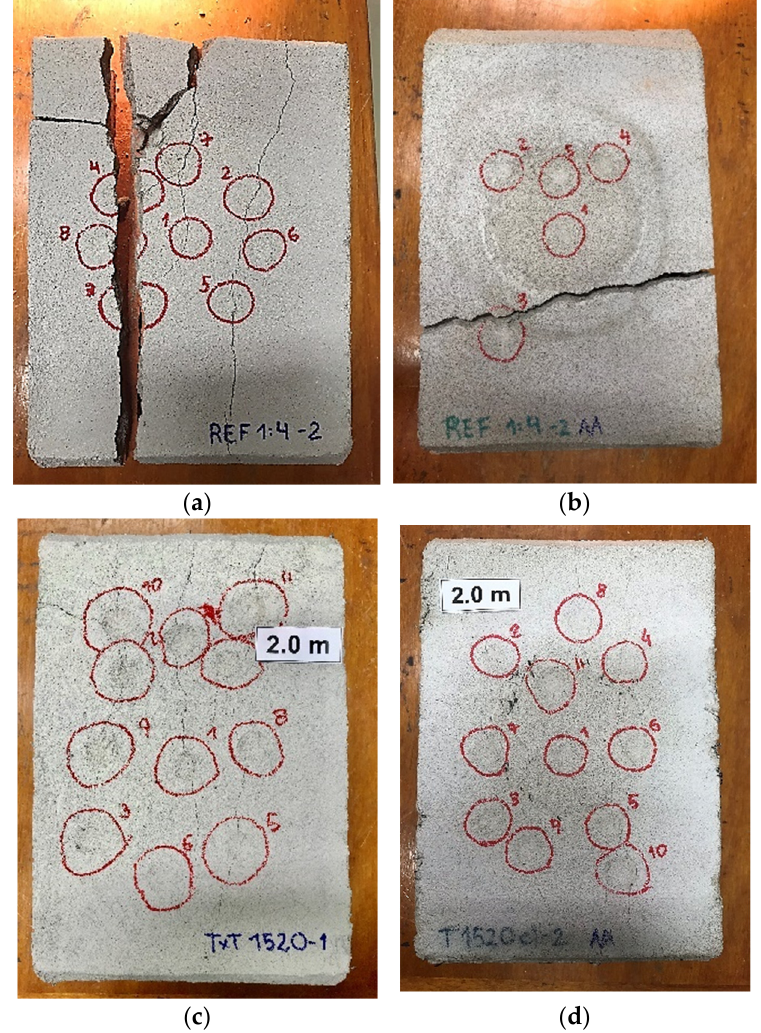
Figure 7. Resistance to impact (failure): REF1:4 mortar ( a ) before ageing and ( b ) after ageing; and T 1520cl mortar ( c ) before ageing and ( d ) after ageing.